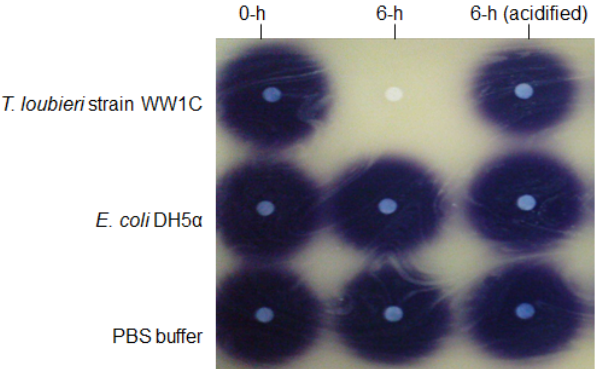
Figure 6. Identification of degradation products of C6-HSL incubated with T. loubieri strain WW1C. C6-HSL incubated with T. loubieri strain WW1C cells for 0 h (0-h), 6 h (6-h), and samples withdrawn at 6 h and acidified (6-h acidified) to promote re-lactonisation. Bacterial names were labeled on the left of the figure. E. coli DH5 α and extraction buffer (PBS 100 mM, pH 6.5) were used as the negative controls. Residual C6-HSL was detected by using CV026 and visualized as purple